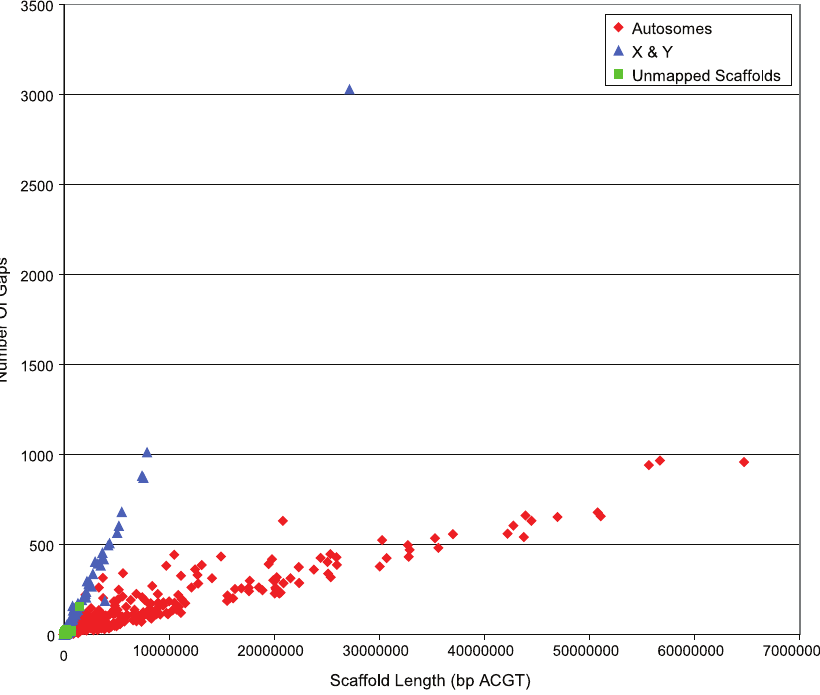
Figure 3. Sequencing Continuity Plot for the HuRef Autosomes Compared to HuRef X and Y Chromosomes Note that the autosomes have more contiguous sequence with fewer gaps compared to chromosomes X and Y, probably due to half the read depth compared to the autosomes and the presence of extensive sequence similarity between the sex